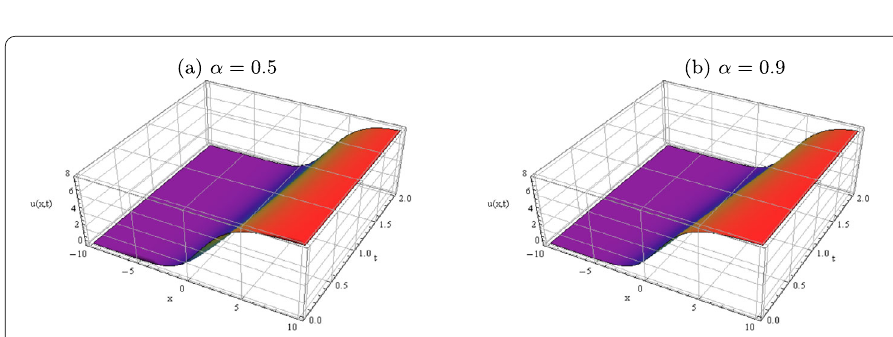
Figure 5 ( a ) The effect of α on the 3D double-layer solution of equation (6.12) with a fixed time t and the parameters k = 0.3, p = 0.2, q = 0.2. ( b ) The corresponding 2D plot of ( a ) which shows that when the value of α increases the interval of the stability of the solution also increases